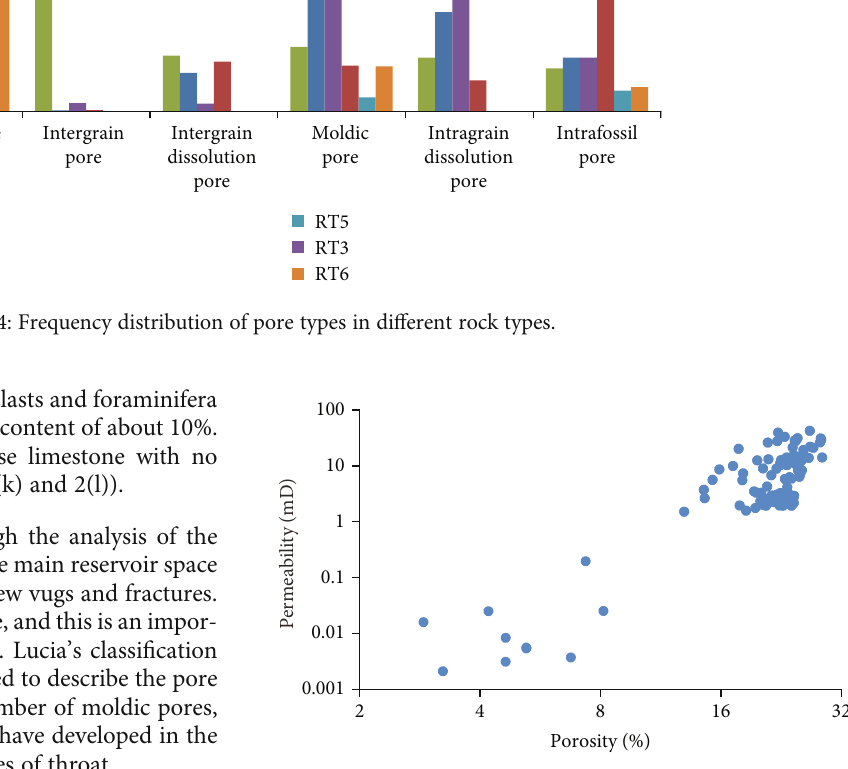
Figure 5: Crossplot of porosity versus